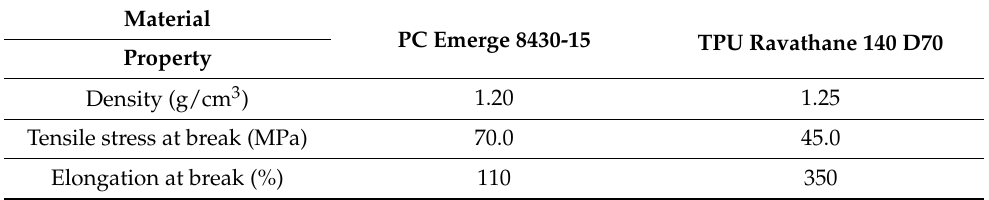
Table 1. Fundamental properties of PC and TPU materials used during this study.